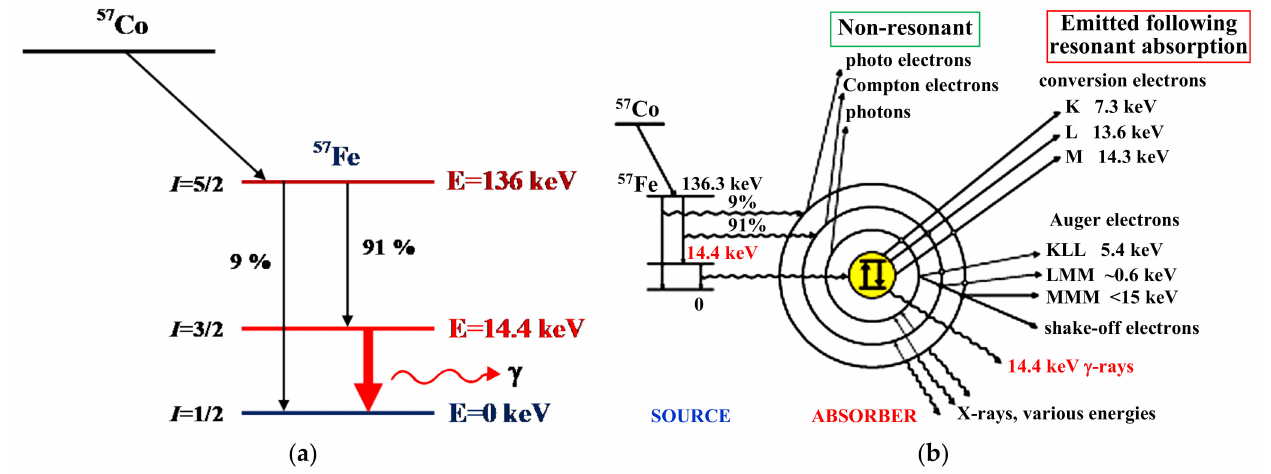
Figure A9. Schemes of 57 Co decay ( a ) and the main pathways of the energy emission following resonant absorption by the 57 Fe nucleus ( b